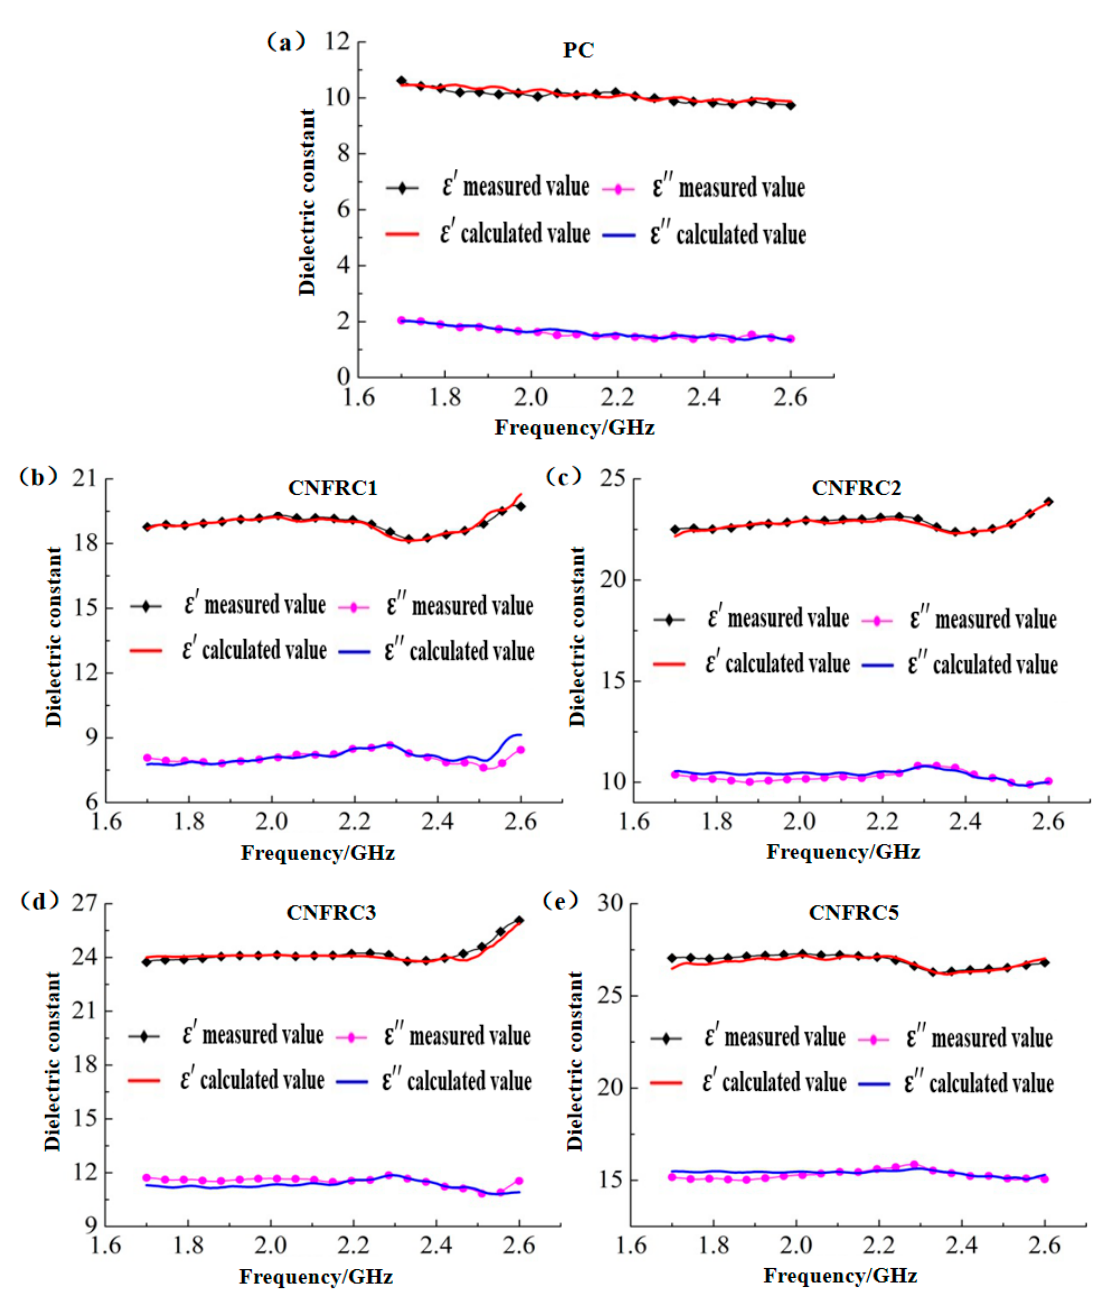
Figure 18. Verification of the measured values with the calculated values based on modified Looyenga model for groups of specimens. ( a ) PC; ( b ) CNFRC1; ( c ) CNFRC2; ( d ) CNFRC3; ( e ) CNFRC5.